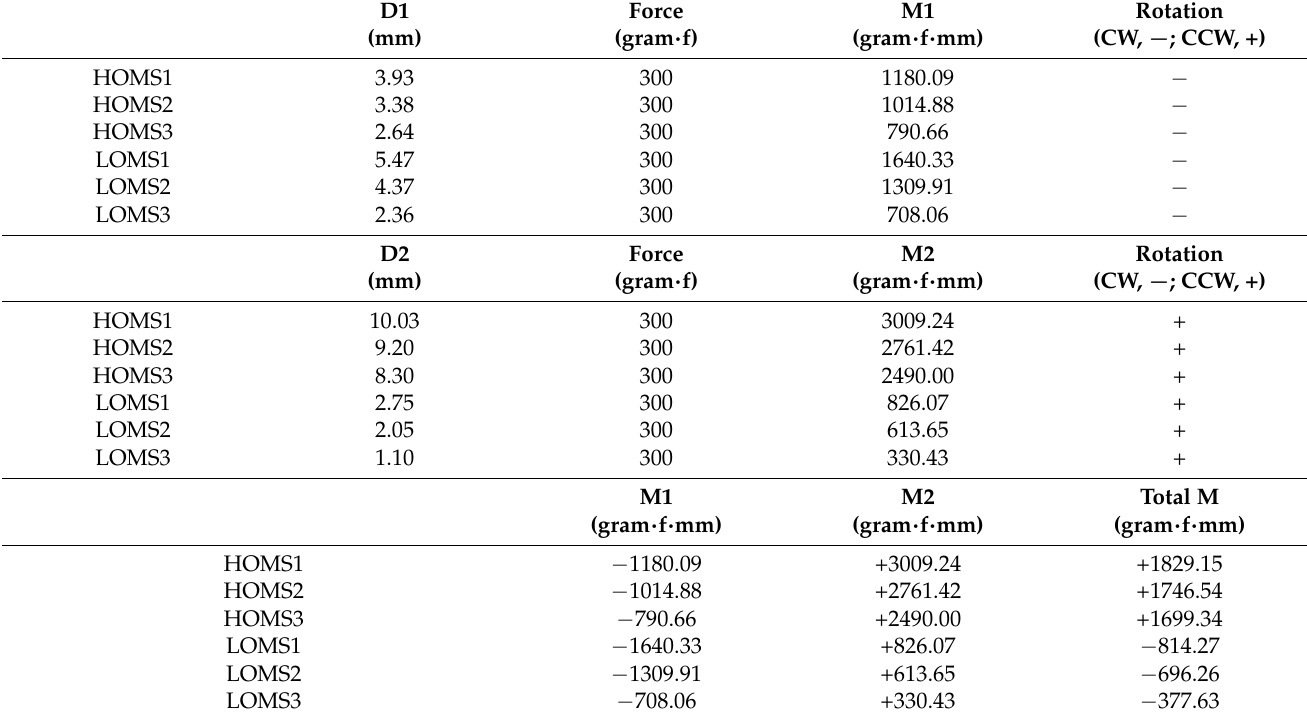
Table 8. Magnitude and direction of moment at initial